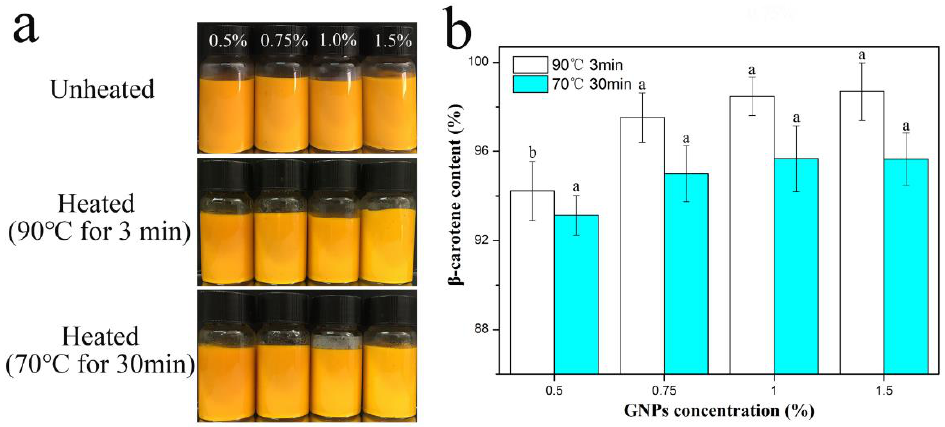
Figure 4. ( a ) The visual images and ( b ) β -carotene retention of GNPs Pickering emulgels at room temperature and pasteurizations conditions.